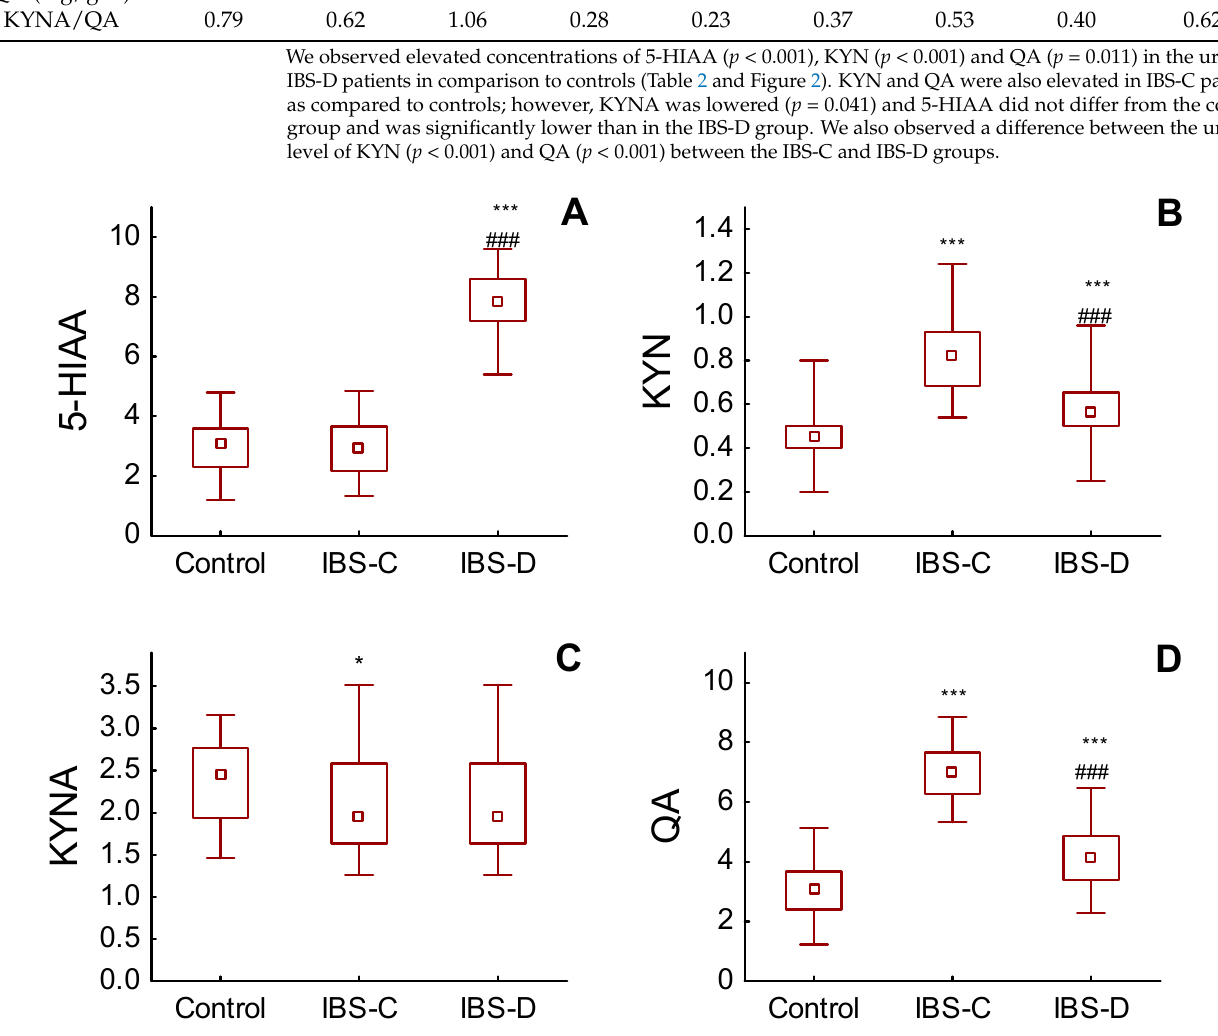
Figure 2. Urinary excretion of ( A ) 5-hydroxyindoleacetic acid (5-HIAA), ( B ) kynurenine (KYN), ( C ) kynurenic acid (KYNA) and ( D ) quinolinic acid (QA) in mg/gCr in healthy subjects (C) and in patients with constipation-predominant (IBS-C) and with diarrhoea-predominant (IBS-D) irritable bowel syndrome (IBS-D); *** p < 0.001, * p < 0.05, ### p < 0.001 between IBS-C and IBS-D. Box and whiskers represent median, IQR and min–max value.